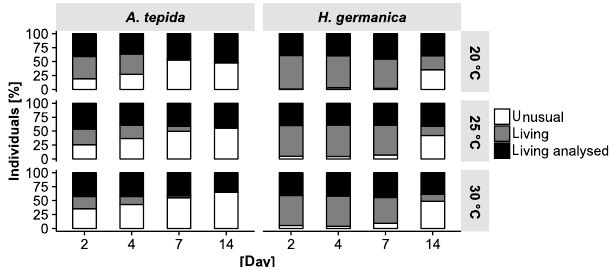
Figure 1. Relative amounts of individuals per sampling day and temperature treatment. The terms “unusual” and “intact” refer to the cytoplasmic appearance of the specimen; additionally the frac- tion of analysed specimen is shown. Unusual cytoplasm includes in- dividuals with patchy distribution of cytoplasm within the test or an unusual coloration. Individuals with intact cytoplasm include for- mer live specimens as described in the